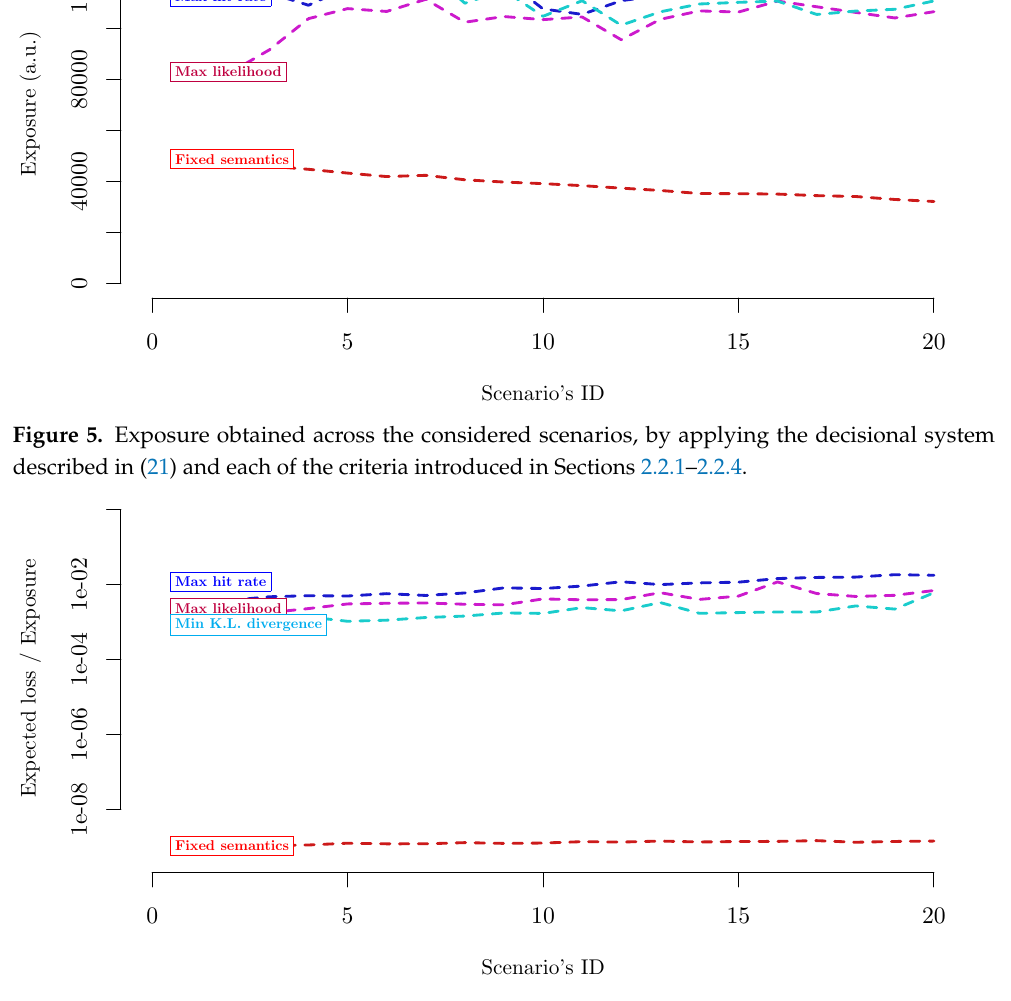
Figure 6. Loss per unit of exposure obtained across the considered scenarios by applying the decisional system described in (21) and each of the criteria introduced in Sections